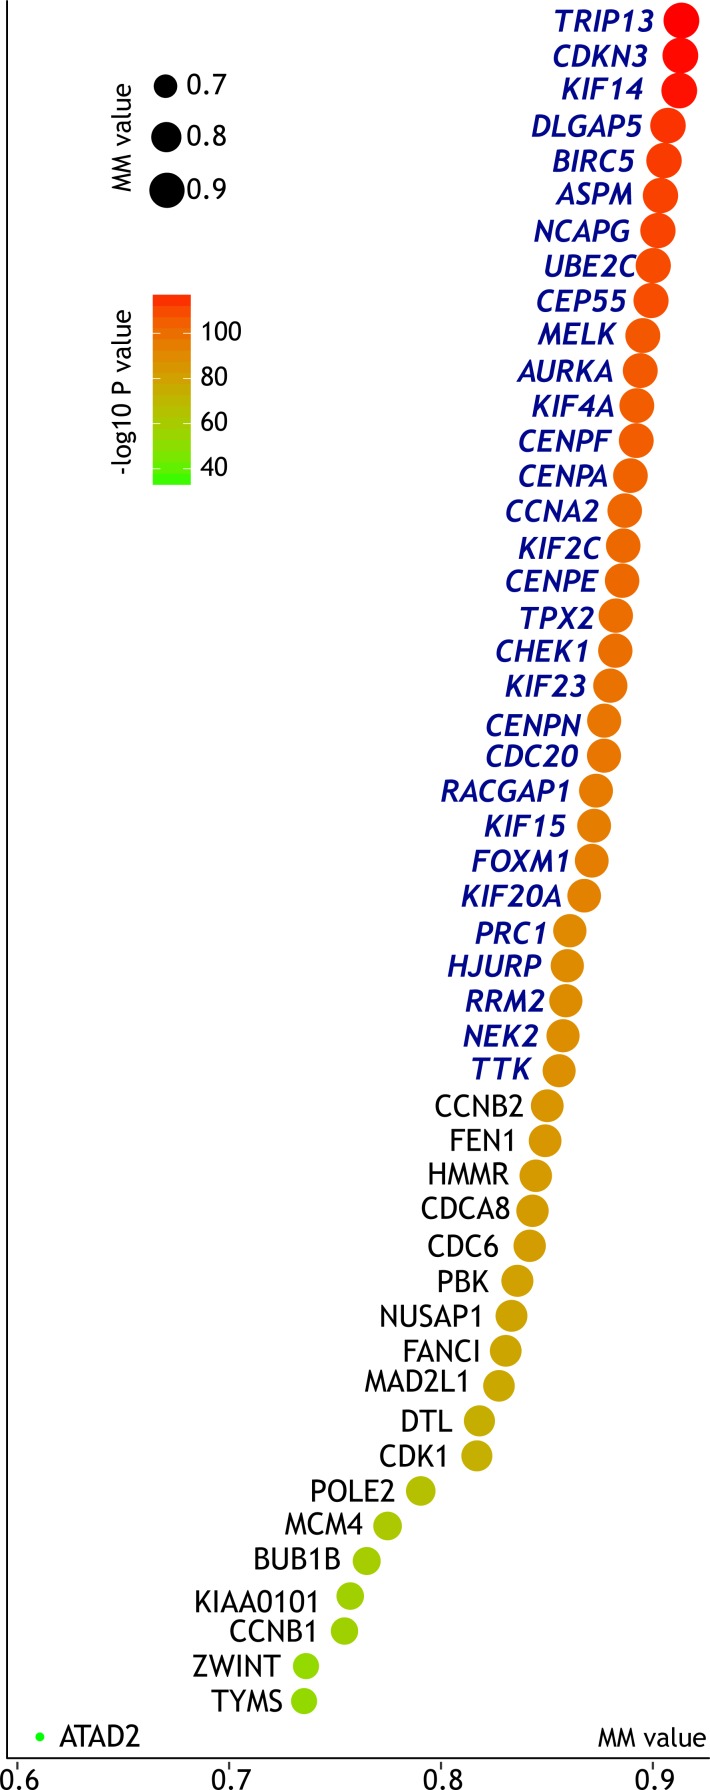
Centrality of the top 50 PPI network-predicted hub DEGs in module turquoise.The horizontal axis together with the size of the bubble represent module membership (MM, reflecting each gene’s centrality in the gene module). The color of bubble represents corresponding P value. Based on the cut-off MM value of 0.85, we further filtered out 31 key as key genes supported by both PPI-based and WGCNA-based prediction, marked in blue italics.